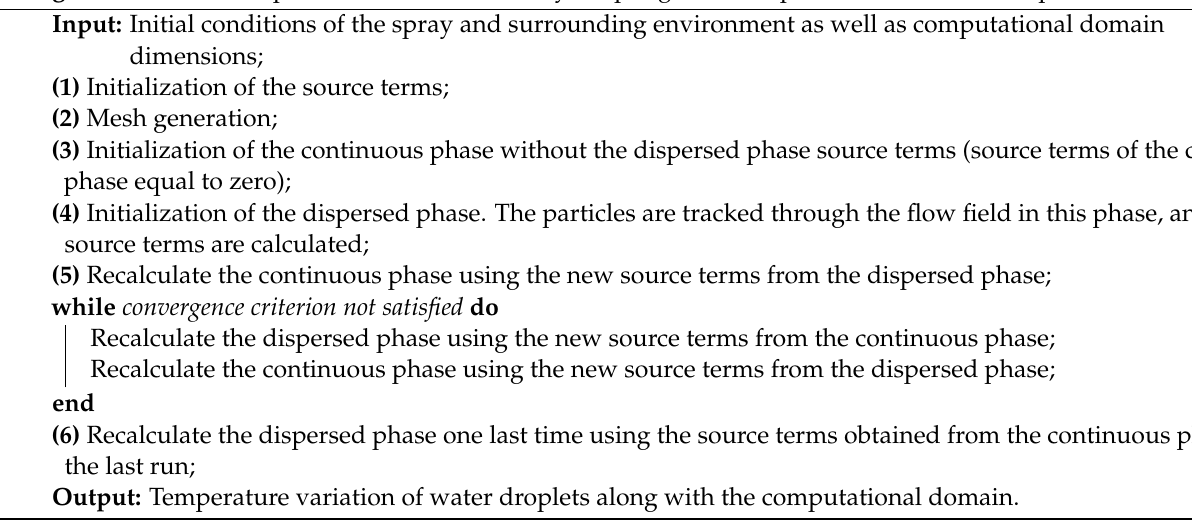
Algorithm 1: Iterative procedure for the two-way coupling of the dispersed and continuous phases. Input: Initial conditions of the spray and surrounding environment as well as computational domain